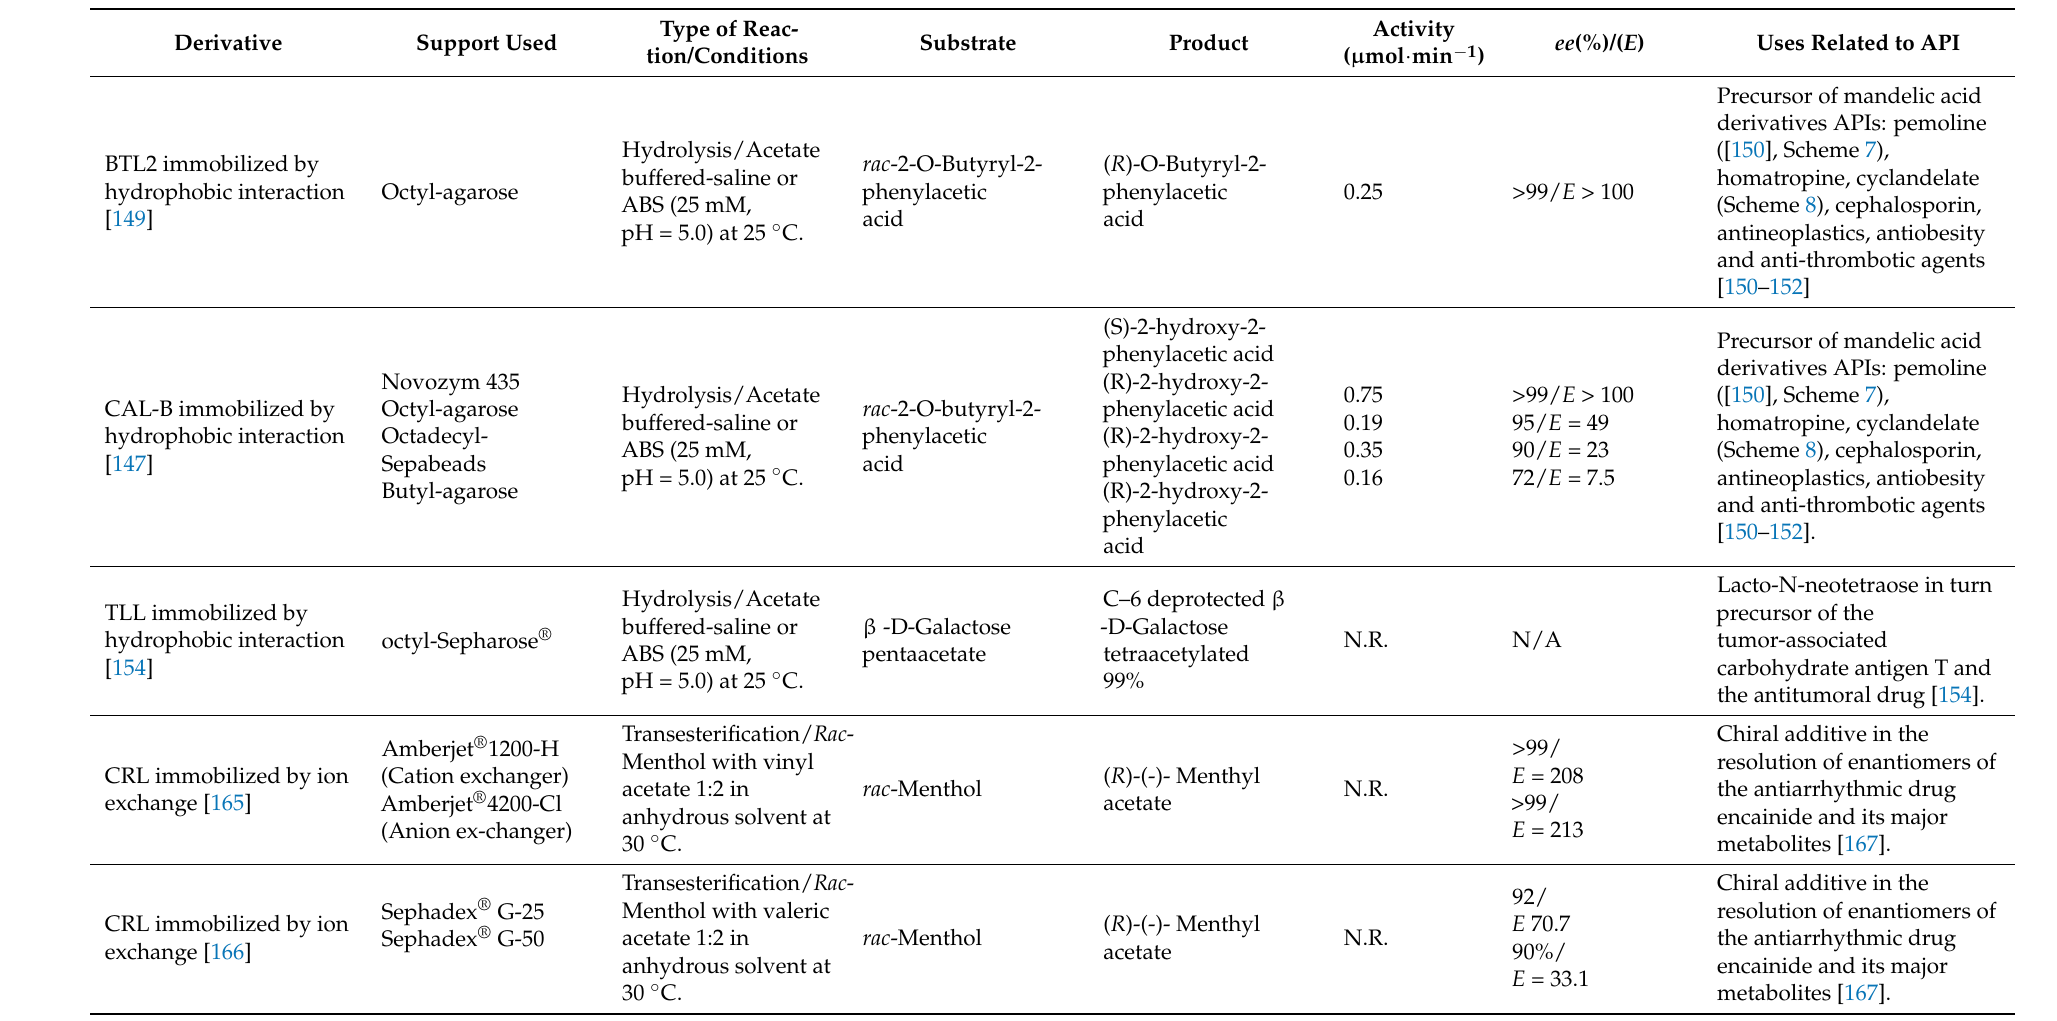
Table 2. Immobilized lipases on hydrophobic interaction and ion exchange supports to obtain